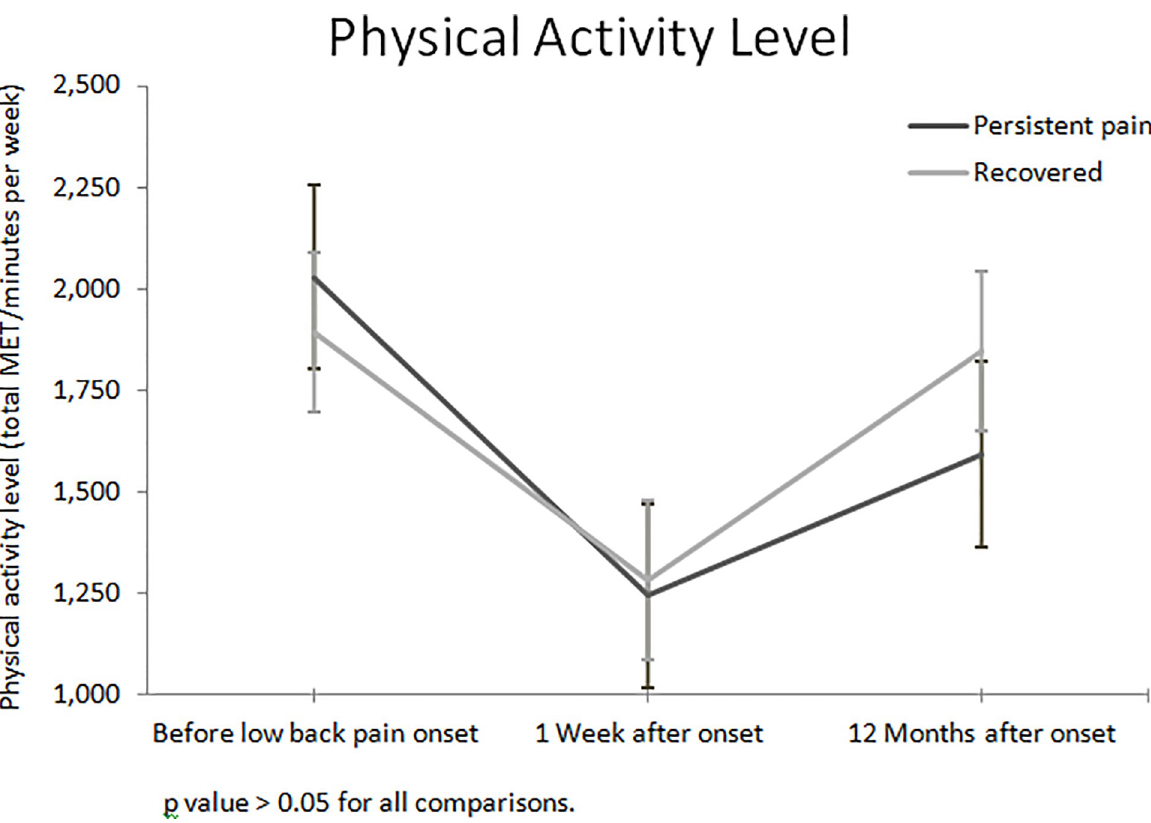
Fig 2. Mean total MET minutes per week at each time-point. p value > 0.05 for all comparisons.